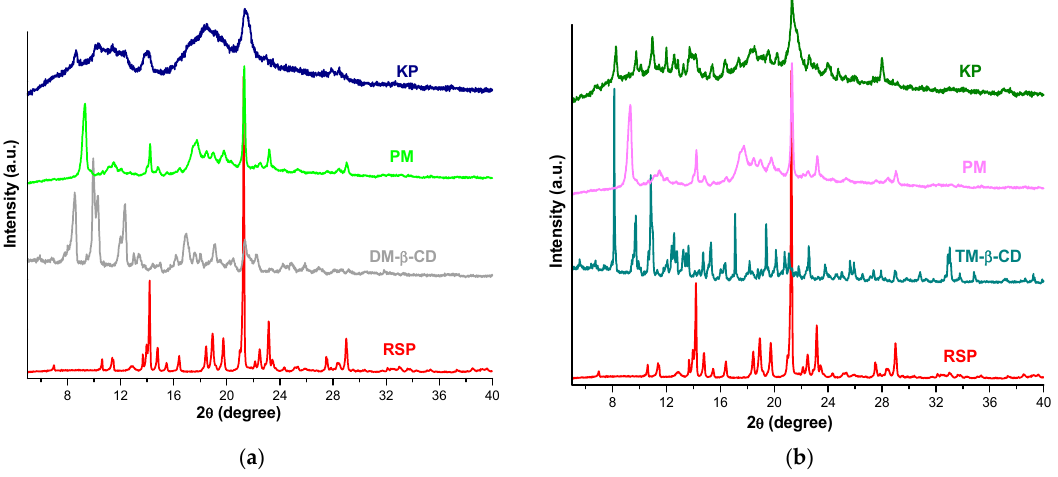
Figure 5. XRD spectra of RSP, DM- β -CD and their PM and KP ( a ); RSP, TM- β -CD, RSP/TM- β -CD PM and KP ( b ).